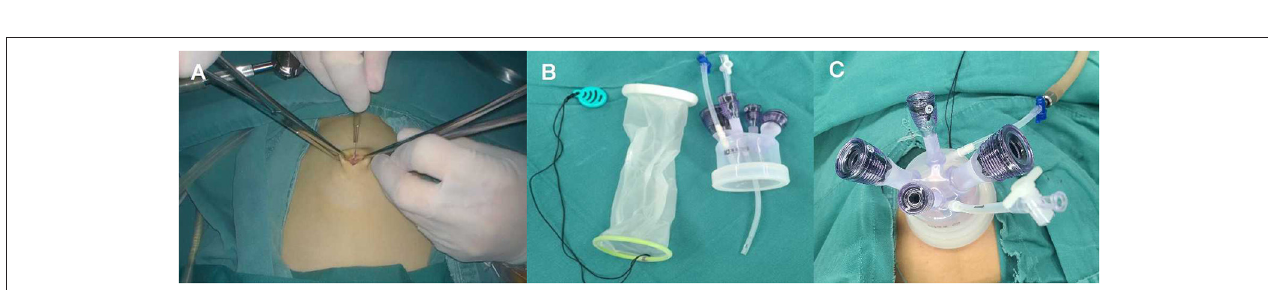
FIGURE 3 | (A) Make a 2-cm umbilical incision. (B) The multichannel single port (Kangji). (C) Set up the port into the intraperitoneal space.